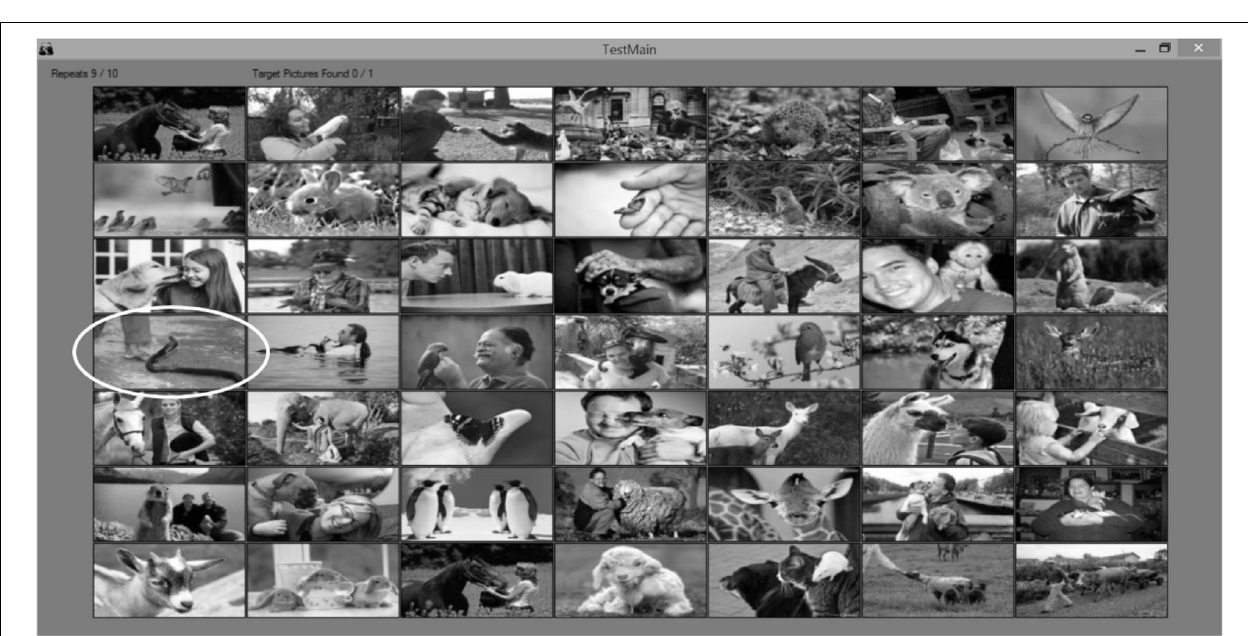
FIGURE 2 | Computerized poisonous animals detection task. Participants are instructed to click as quickly as possible with the left button of the mouse on the target picture, which portray poisonous animals. An example of a target picture is marked by a white oval shape.